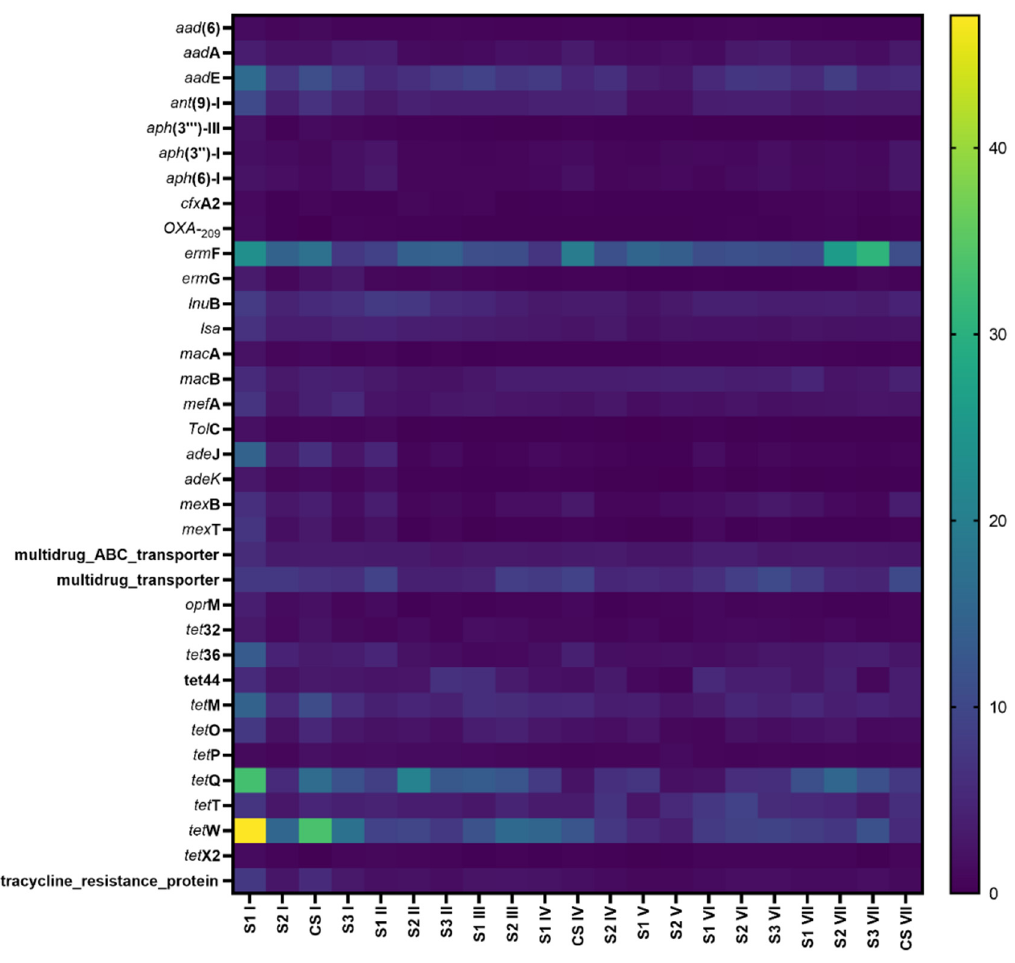
Figure 5. Heatmap presenting the abundance (ppm) of ARG subtypes in the experimental samples (S1, S2, S3) collected from seven experimental series (I–VII) and in control samples (CS). The dominant tetracycline resistance genes were tet 32, tet 36, tet 44, tet M, tet O, tet P, tet Q, tet T, tet W, tet X2 and tetracycline_resistance_protein . These ARG subtypes encode two mechanisms of specific tetracycline resistance. tet 32, tet 36, tet 44, tet M, tet O, tet P, tet Q, tet T and tet W genes are linked with ribosomal protection proteins (RPP), whereas tet X2 en- codes a tetracycline-degrading enzyme [83]. The RPP mechanism is more ubiquitous in the environment, which explains the presence of the identified tetracycline resistance genes in this study. In the work of Santamaria et al. [84], genes encoding RPP were also most abundant in cattle manure. Numerous researchers have reported that cattle manure is a reservoir of ARGs encoding RPP. Therefore, the AD of cattle manure contributes to the spread of tet genes in bioreactors and crop fields. This observation was confirmed by